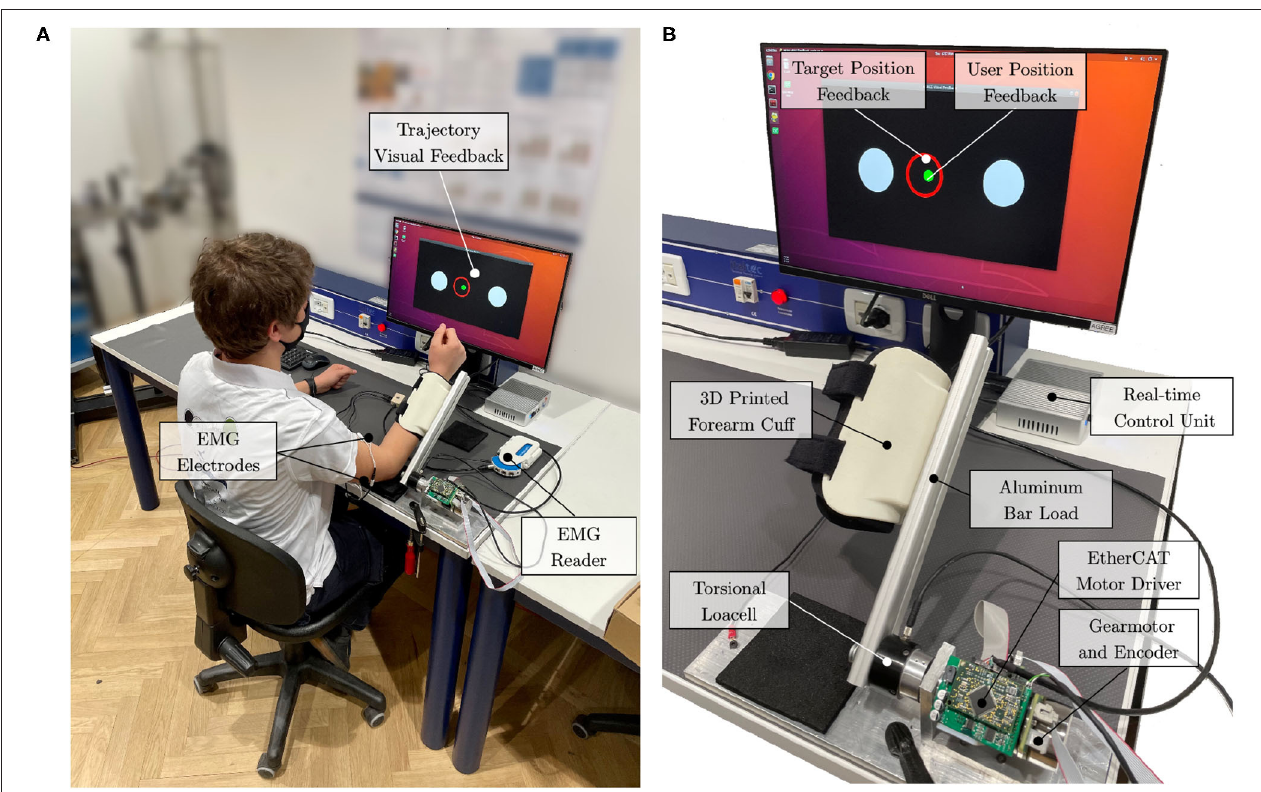
FIGURE 5 | Experimental setup. (A) The subject is attached to the elbow-joint system at the forearm. The elbow leans on the table over a soft foam surface. Surface electrodes are placed at the biceps and triceps brachii (long head). (B) The actuation drive system is connected to the real-time control unit with EtherCAT. Visual feedback is provided to the user to help follow the desired trajectory.